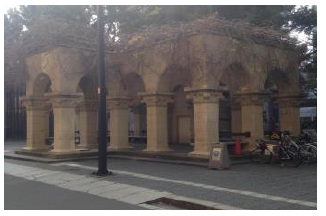
Figure3. Photography target